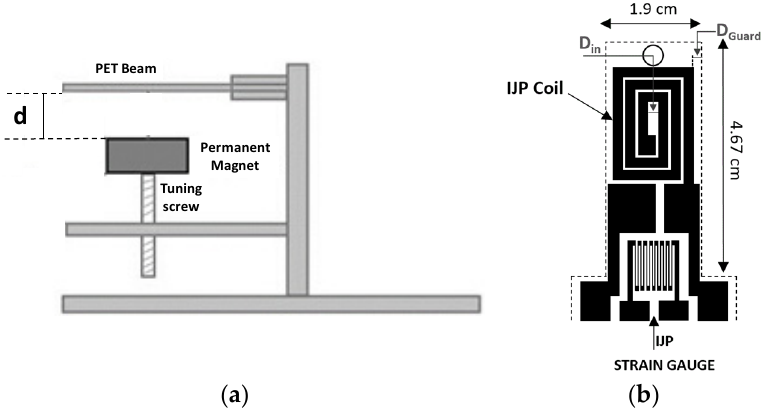
Figure 1. ( a ) Schematization of the mass sensor architecture and ( b ) layout of the inkjet-printed components.